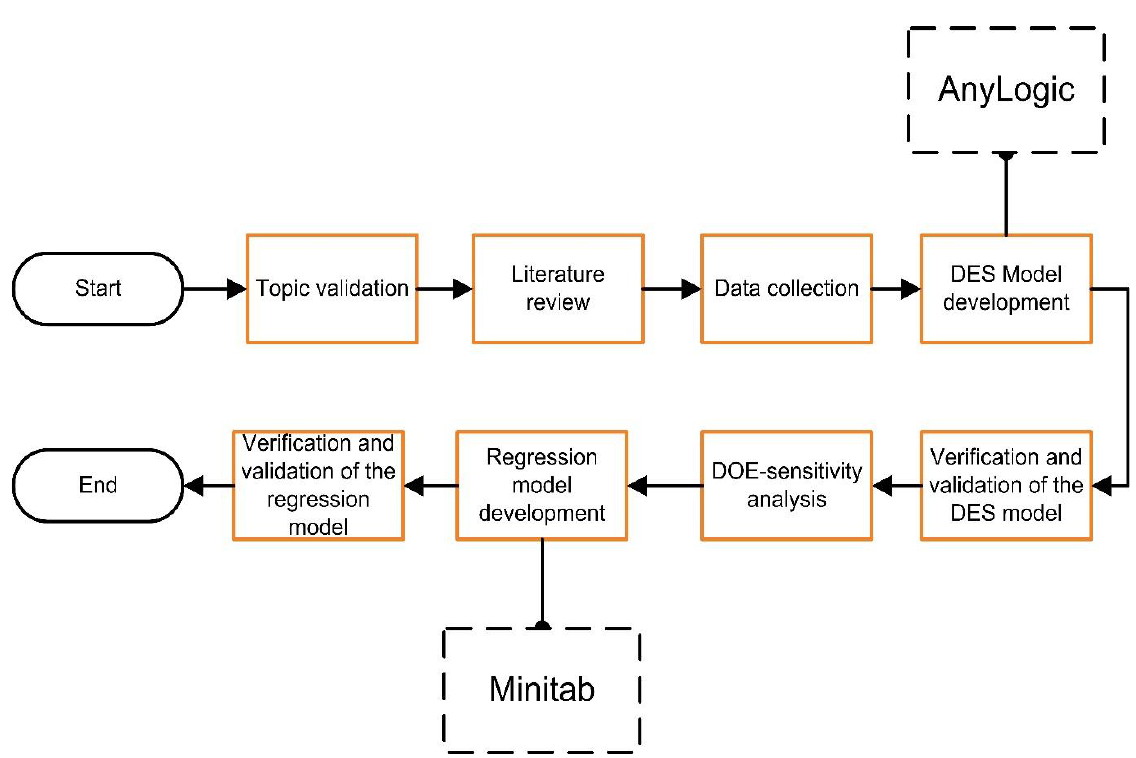
Figure 2. The research